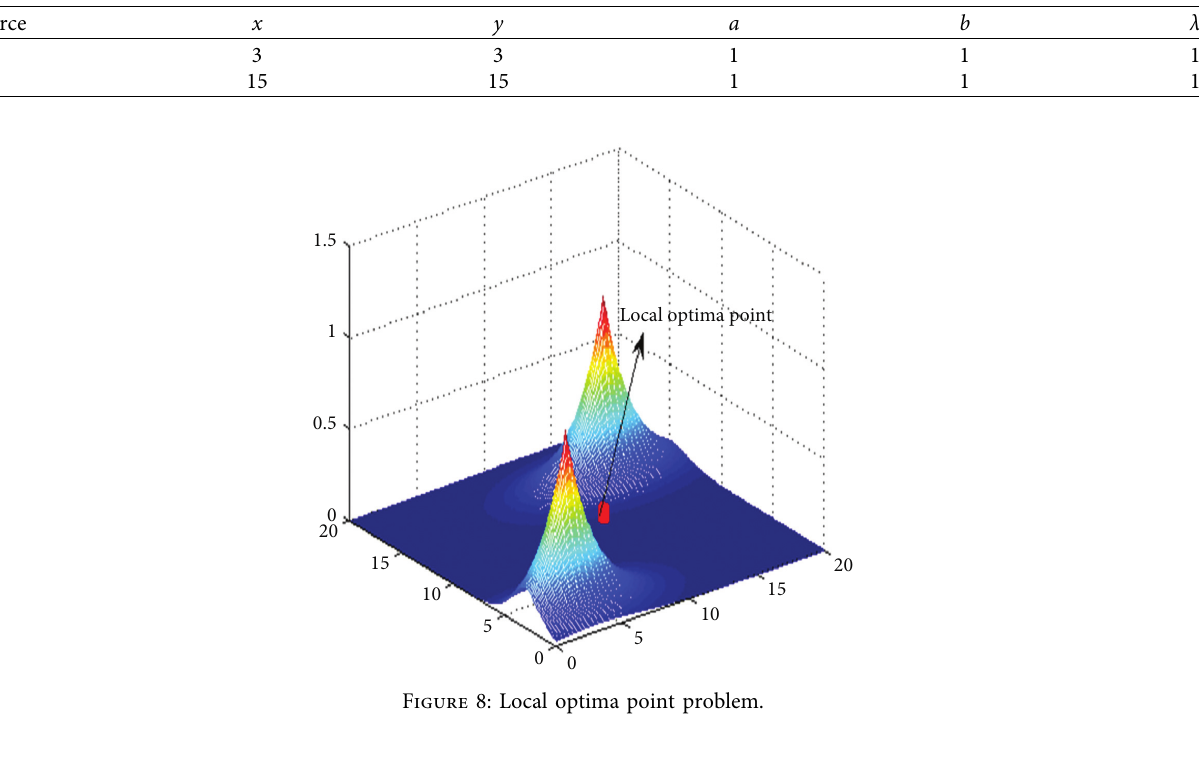
Table 2: The source properties.